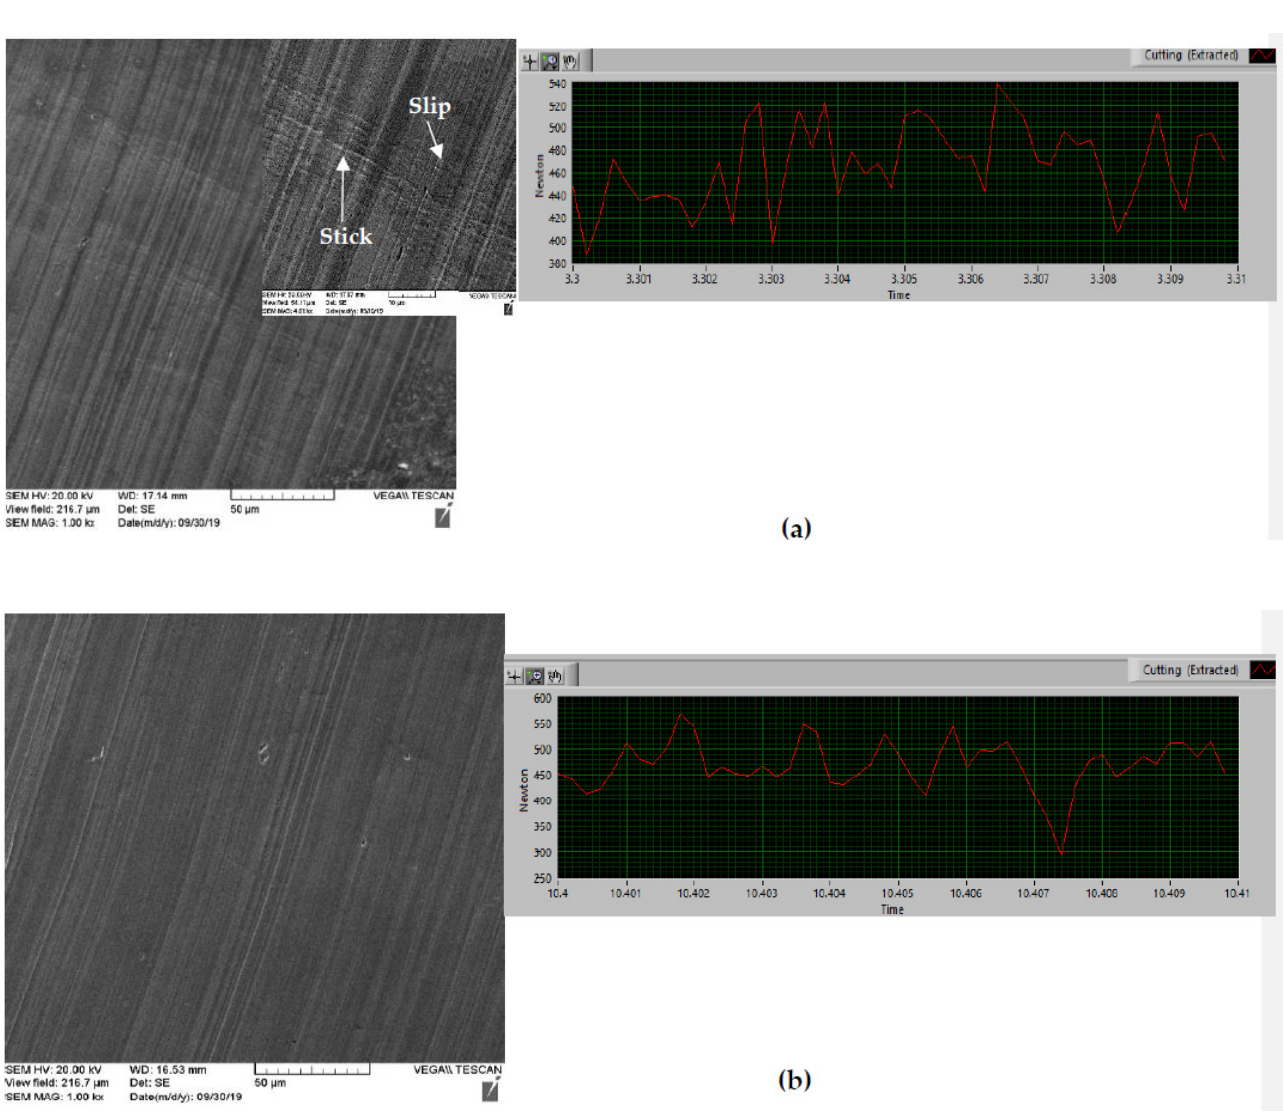
Figure 7. Typical chip undersurface (1000×) and cutting force data: ( a ) stick–slip phenomenon; intensive cutting force fluctuations at the moment of buildup edge formation; ( b ) predominant slip phenomenon at the moment of buildup de- tachment.